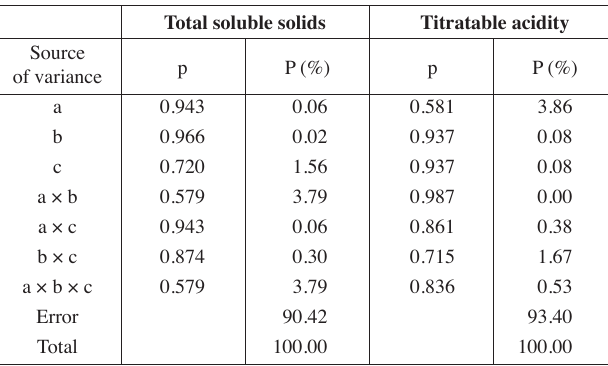
Tab. 2: ANOVA table for total soluble solids and titratable acidity.